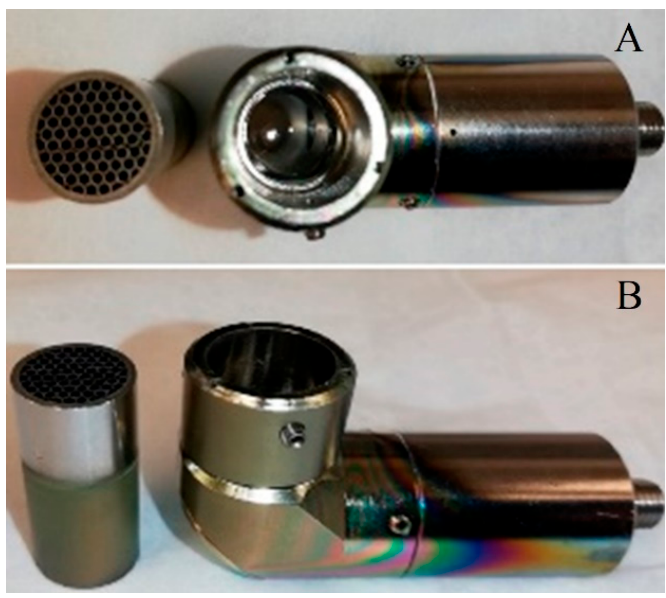
Figure 3. The sputtering chamber, illustrating the position of the collimator. To prevent sputtered material covering the collimator lens, a honeycomb-like structure was fitted to the front, as illustrated in Figure 4.